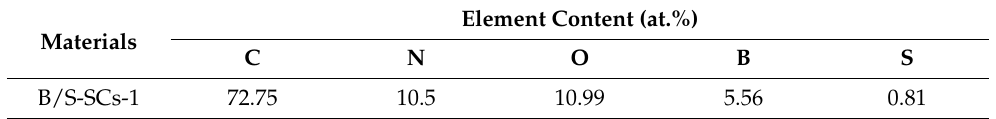
Table 1. The element contents in the as-prepared samples determined by XPS.